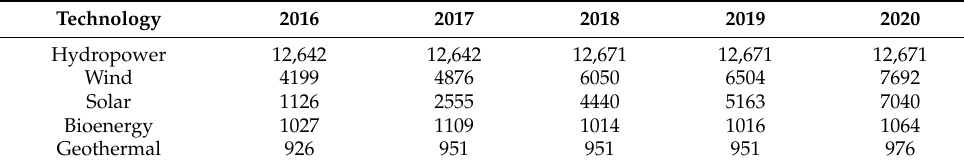
Table 2. Growth of RE by type of technology in Mexico.